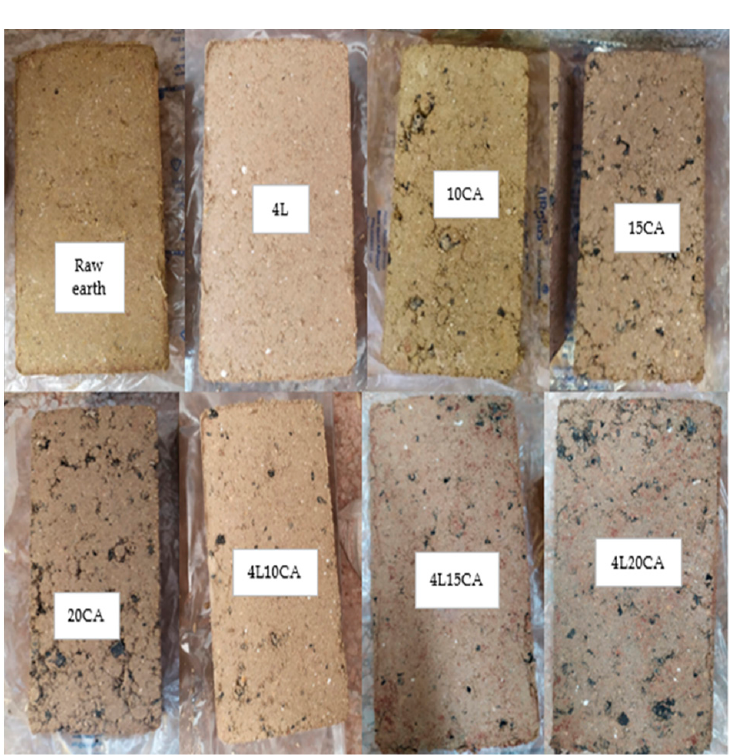
Figure 7. Particle size analysis of the reconstructed soil with 10%, 15%, and 20% of CA according to standards [30,43].